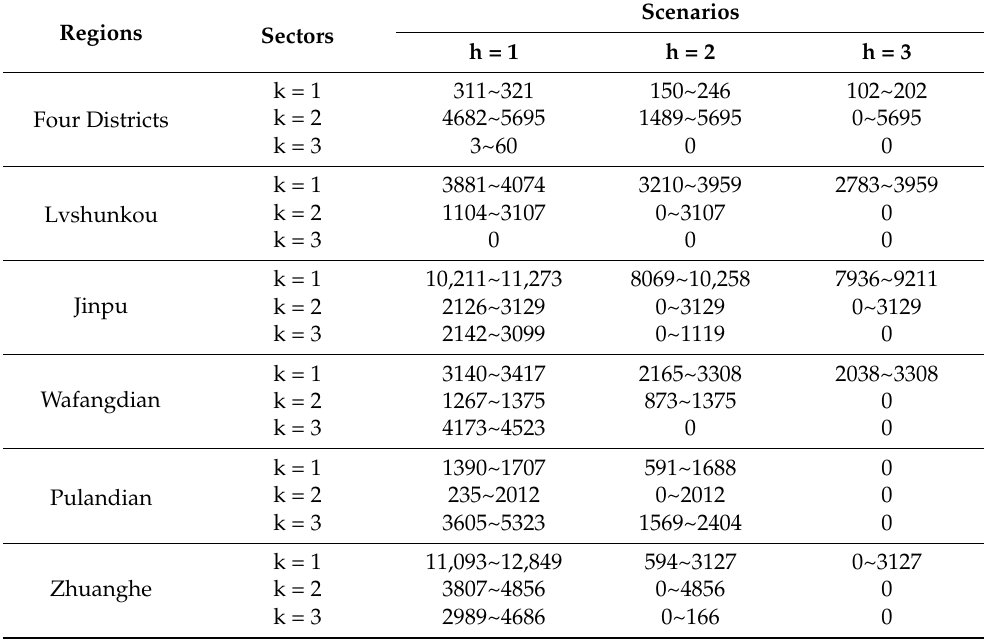
Table 3. Upper and lower bounds of water resource deficit for each sector under different scenarios in period 1 (10 4 m 3 /year).